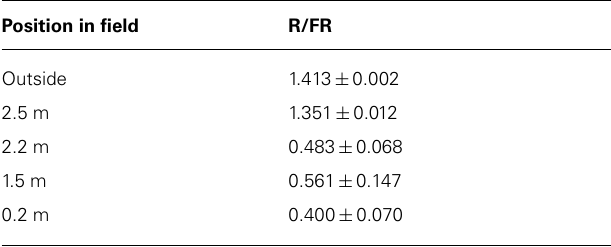
Table 1 | Ratio of short and long wavelengths in the different field stories. Position in field